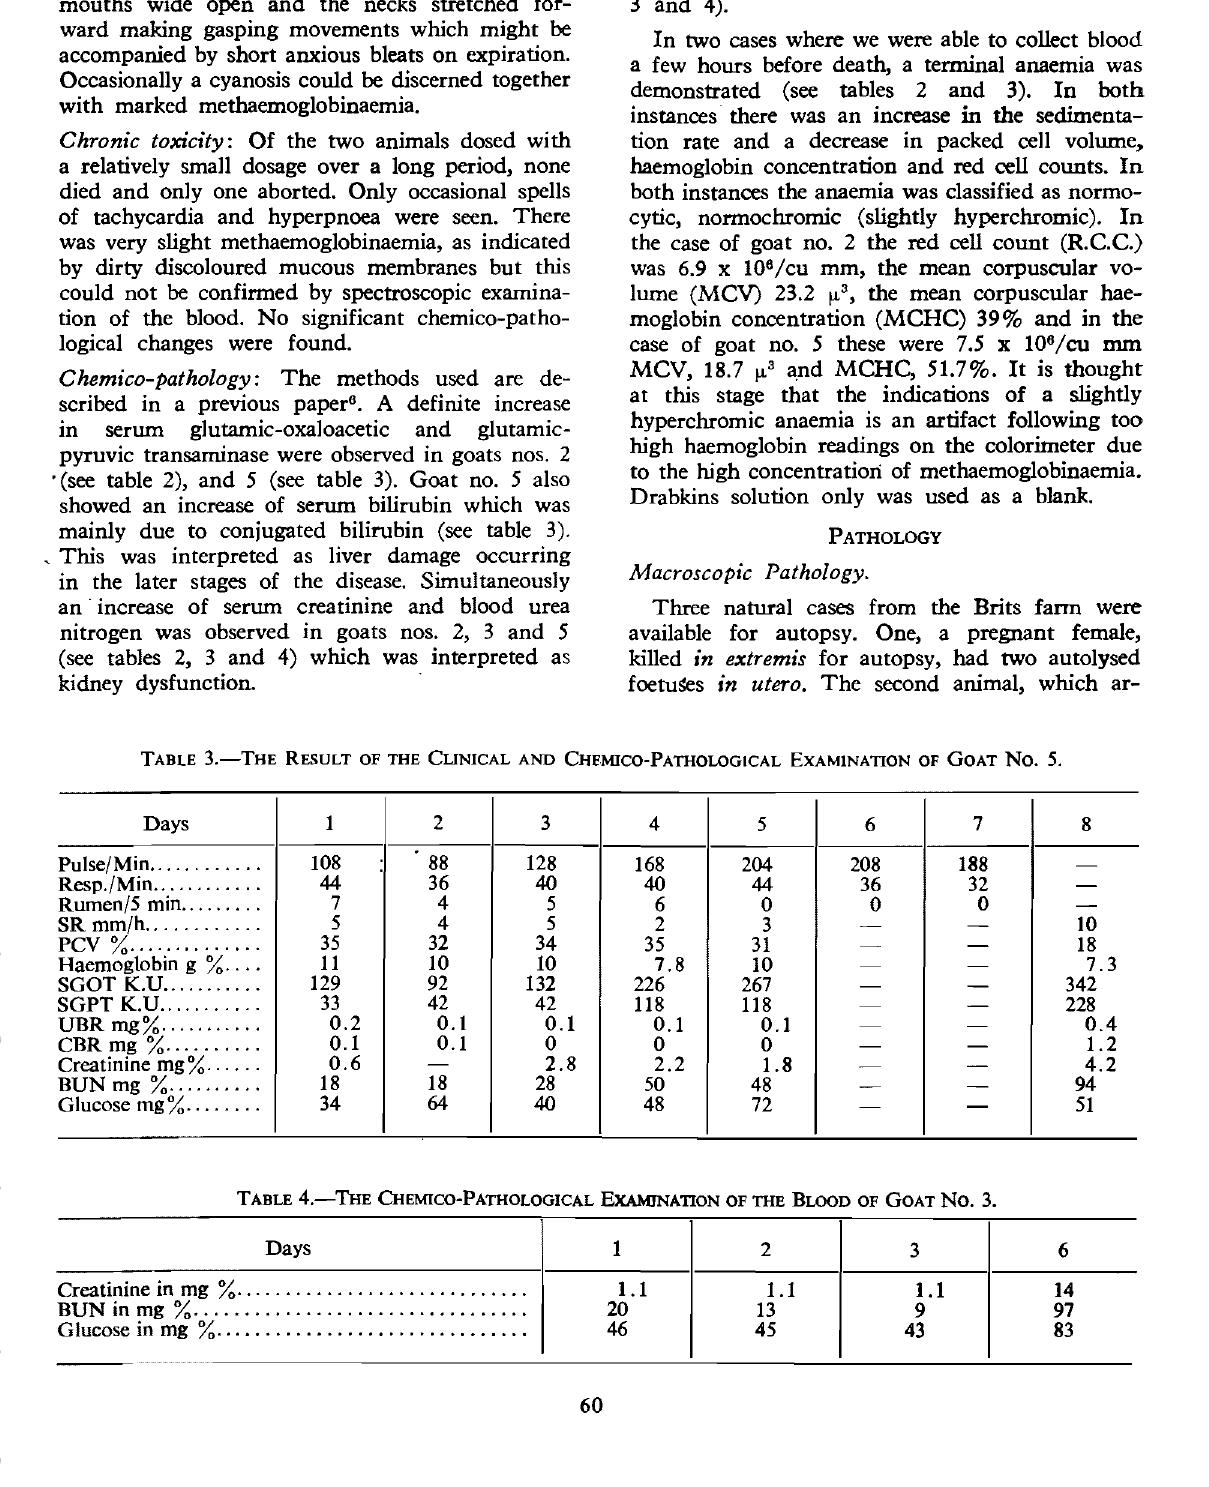
TABLE 4.-THE CHEMICO-PATHOWGICAL EXAMTNATION OF THE BLOOD OF GOAT